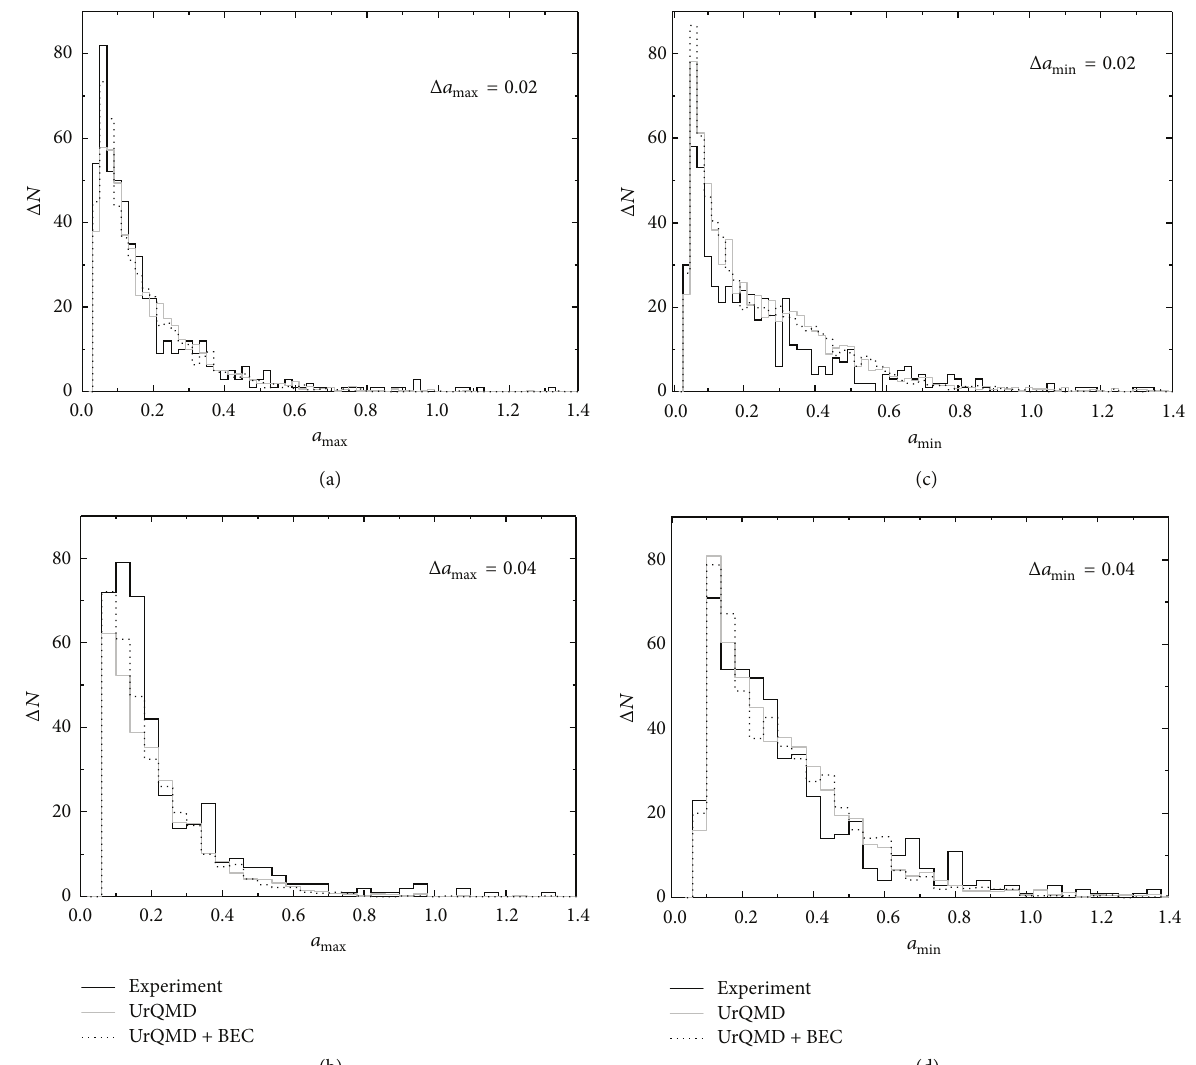
Figure 6: Distributions of the local maxima (left panel) and minima (right panel) of the scalograms for 28 Si-Ag/Br interaction at 14.5AGeV.